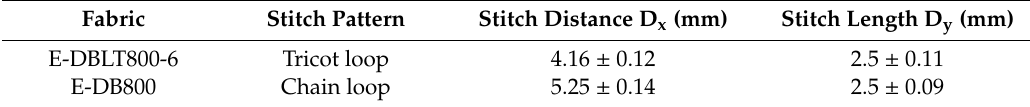
Table 3. Stitching parameters of quadriaxial NCF and biaxial NCF.